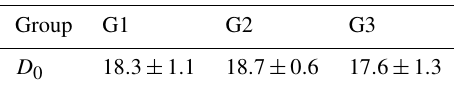
Table 5. D 0 values computed from the curve fit for the different airspeed groups. The uncertainties represent the 1 σ intervals that are associated with the curve fit.